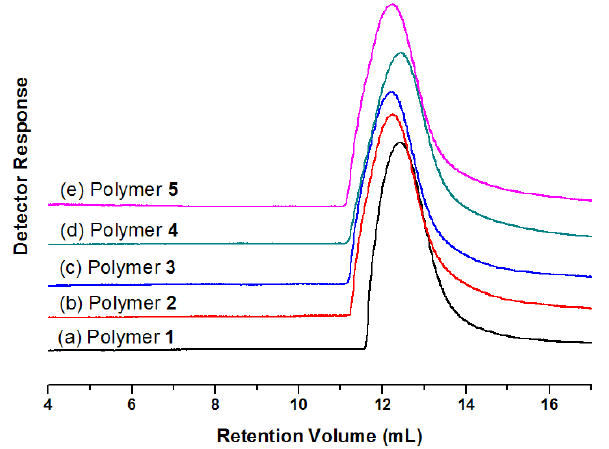
Figure 2. Gel permeation chromatography (GPC) plots (2 mg/mL in DMSO with 0.01 M LiBr) of polymers 1 − 5 . Table 1. Molecular weights of poly(pyridinium salt)−fluorene s 1 – 5.